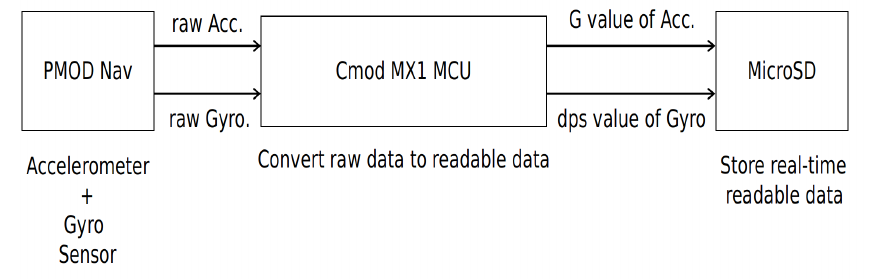
Figure 1. Block design for the